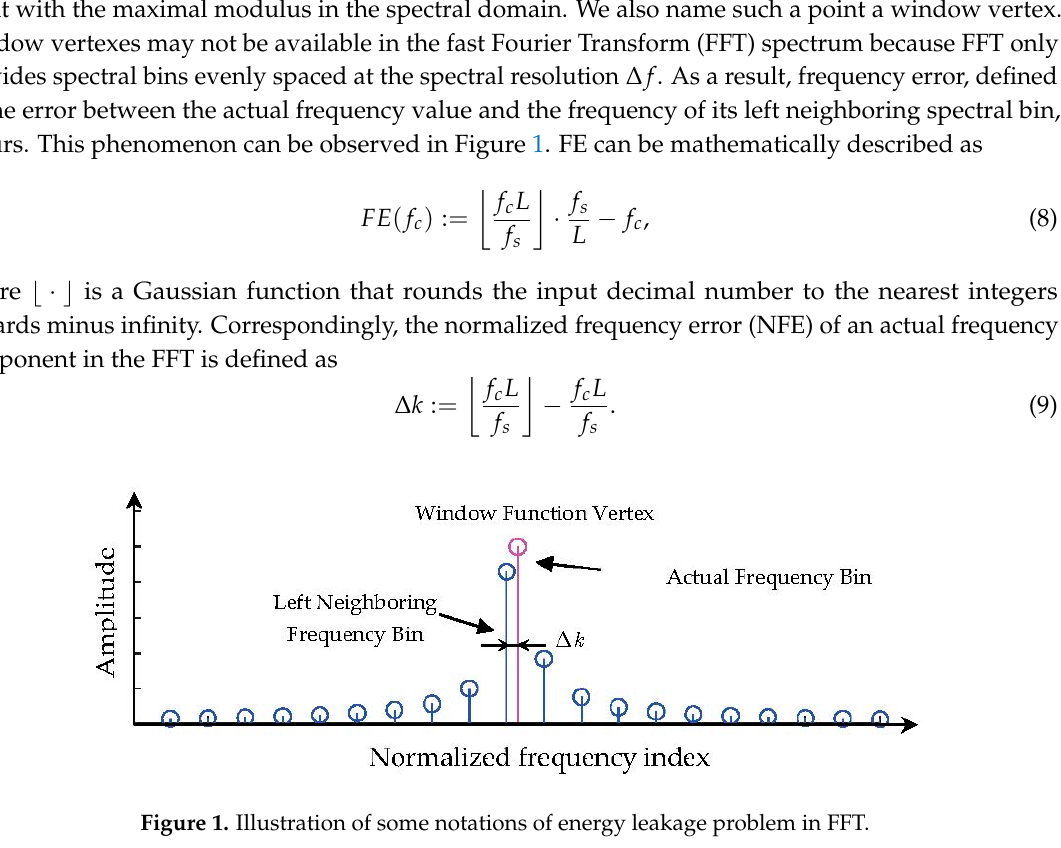
Figure 1. Illustration of some notations of energy leakage problem in FFT.